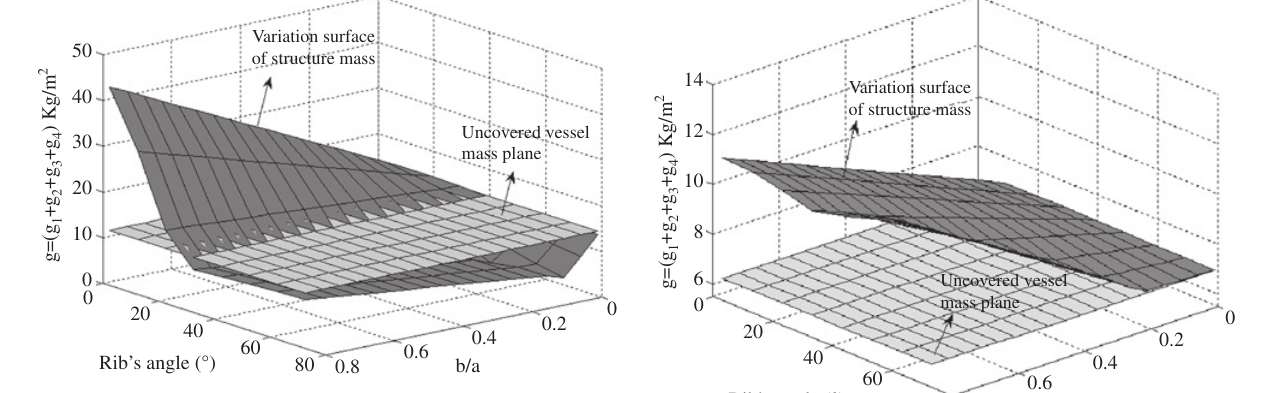
Figure 9 Variation of the structure mass with ϕ and ( b / a )